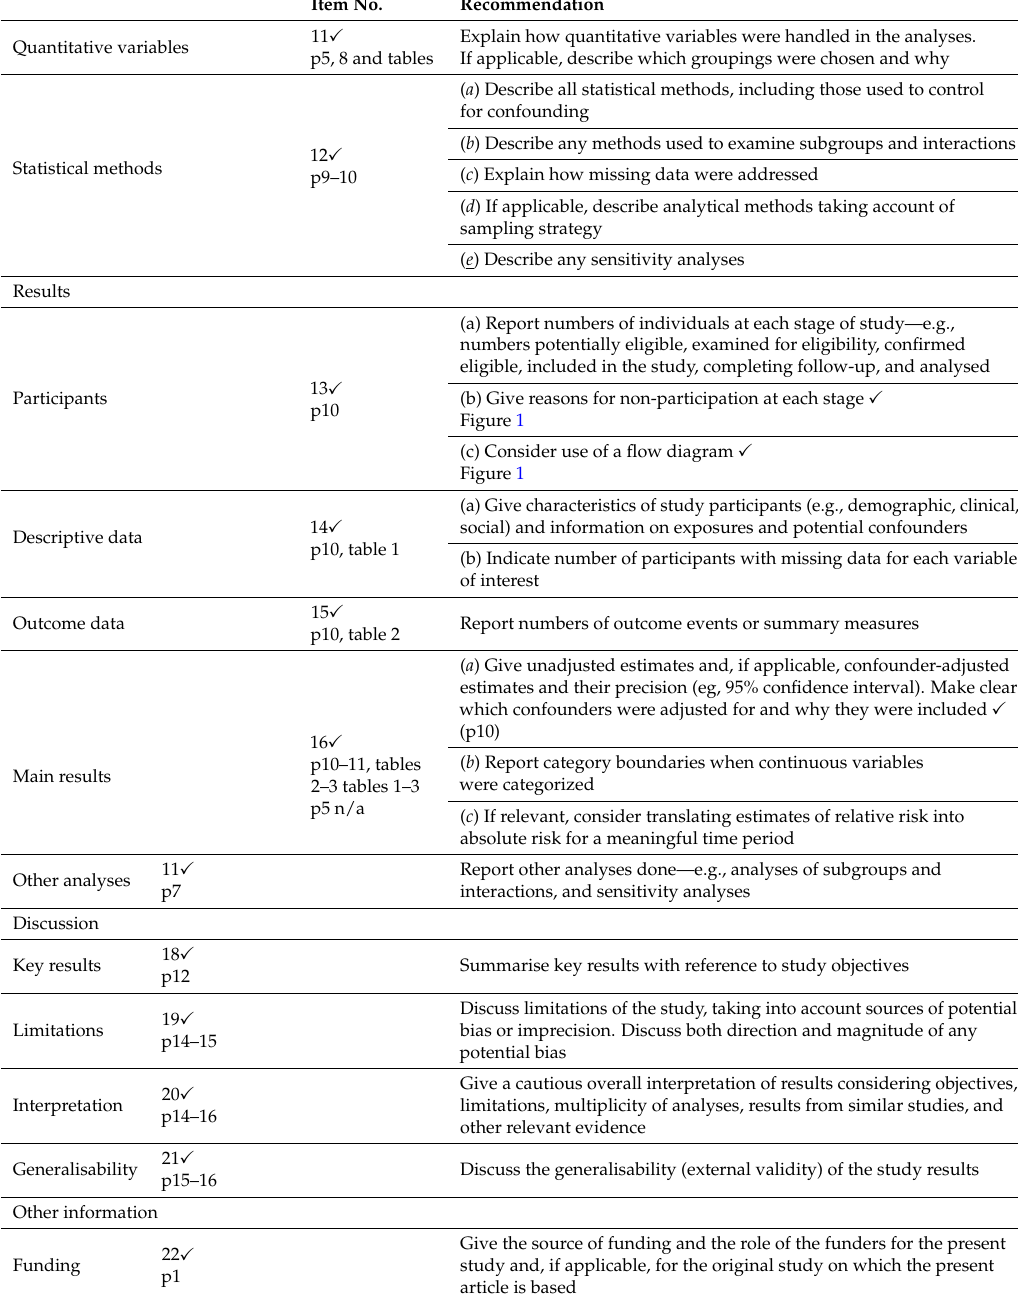
Table A2. Final model results after implementation of propensity score matching to the sample of children inhabiting repeatedly flooded and non-flooded villages. Table B1. STROBE Statement—Checklist of items that should be included in reports of cross-sectional studies. Table B1. Cont.